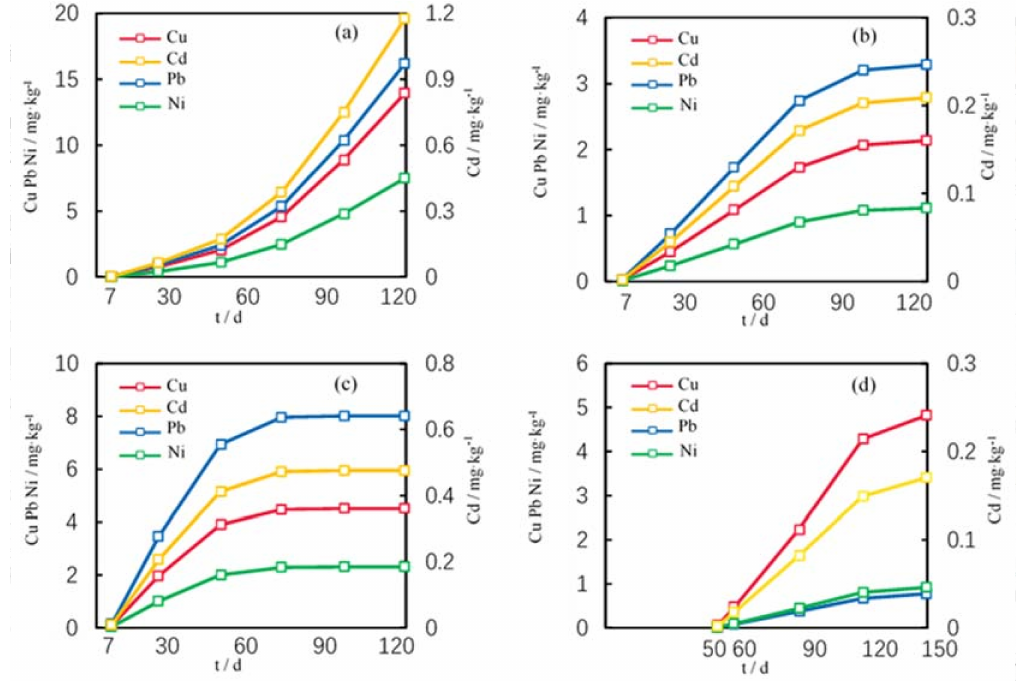
Figure 5. The accumulation process of Cu, Cd, Pb and Ni in wheat parts. ( a ) Root ( b ) Stem ( c ) Leaf ( d ) Grain. Table 4. The modeling results of trace metals contents in wheat/mg · kg − 1 . Element